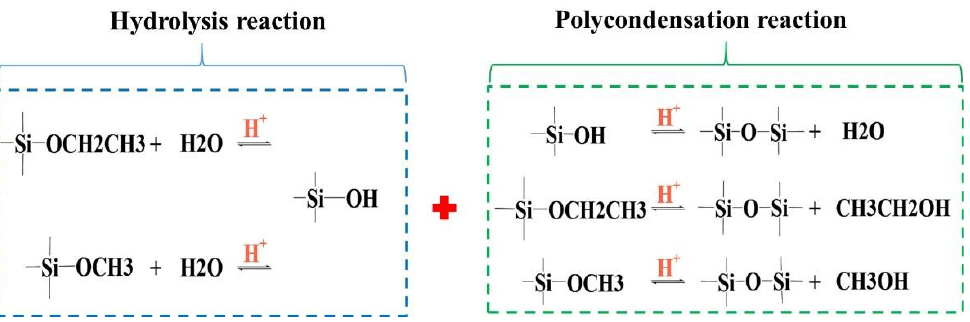
Figure 3. Schematic diagram of hydrolysis and condensation reactions of alkoxysilane monomers.